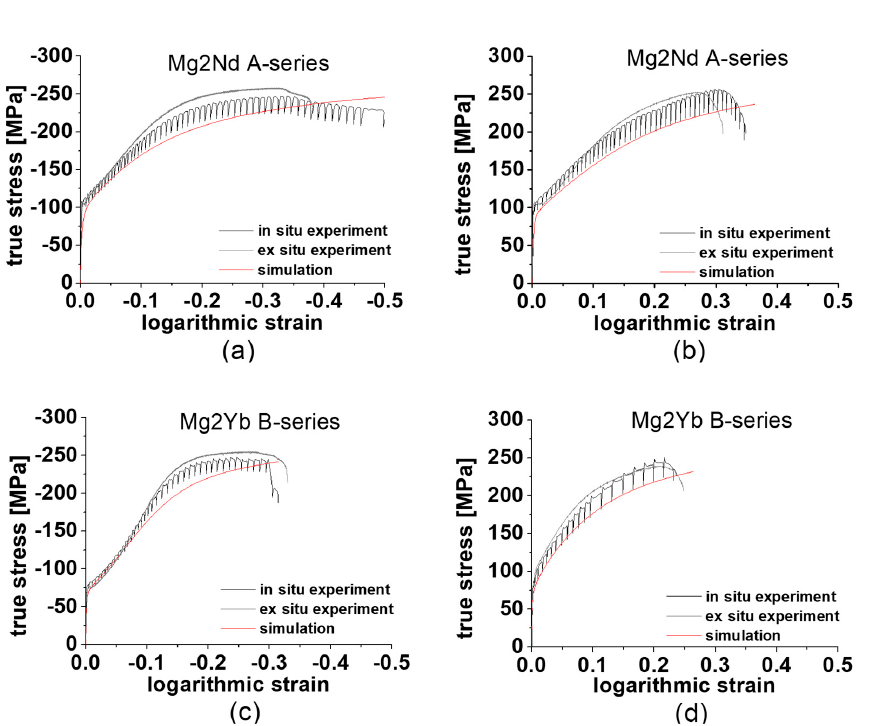
Figure 3. Comparison of the flow curves from the in situ experiment, ex situ experiment and the simulation of the Mg2Nd Table 2. Mechanical properties of the investigated alloys (the error of compressive yield strength (CYS) and tensile yield strength (TYS) is below 5 MPa, the error of ε fc and ε ft is below 0.02).